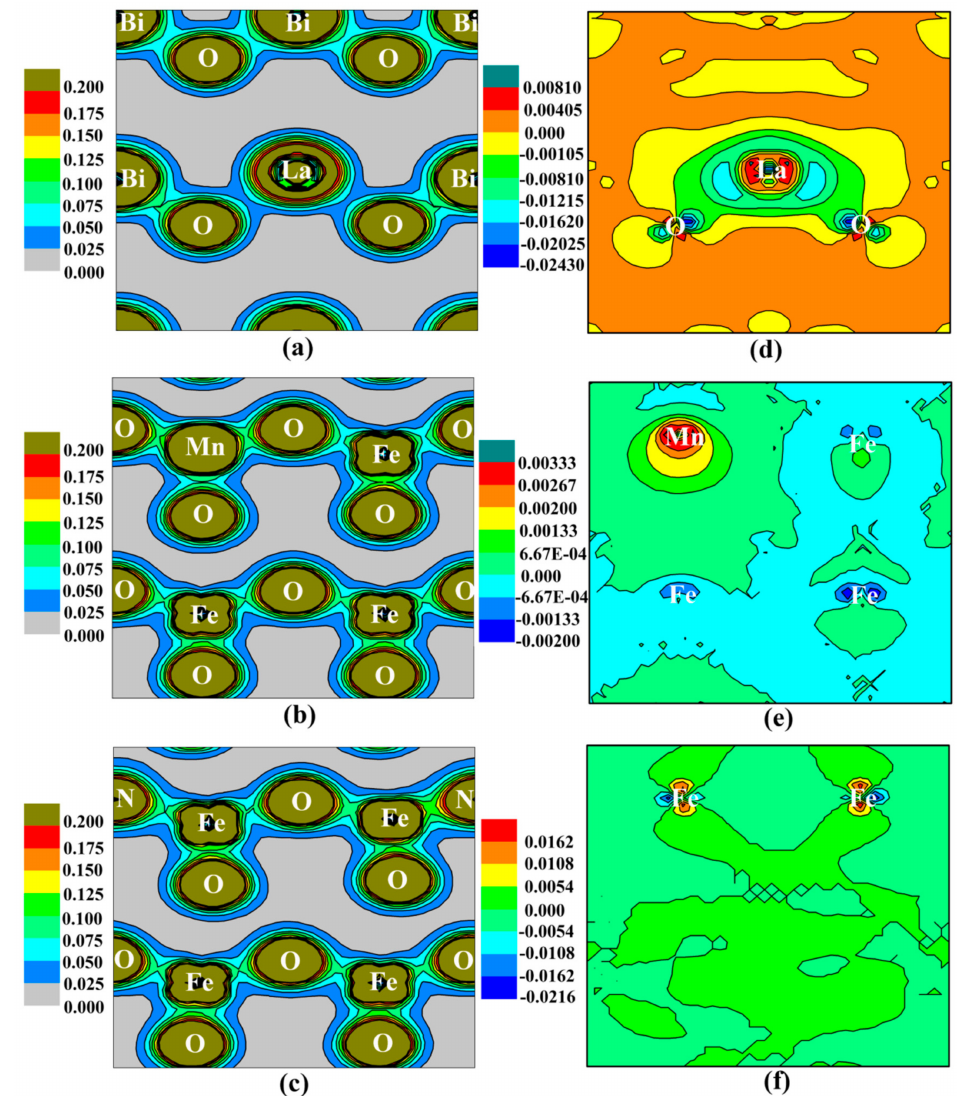
Figure 5. ( a – c ) The charge density (e/a.u. 3 ) and ( d – f ) the difference charge density (e/a.u. 3 ) for La-, Mn-, and N-doped tetragonal BFO supercell,